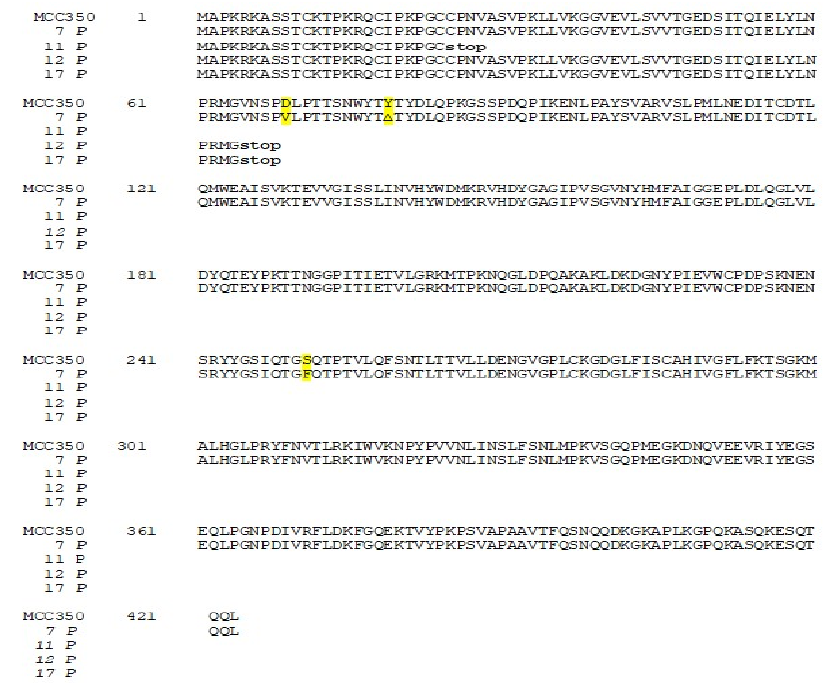
Figure 6. Amino-acid analysis of MCPyV VP1 in plasma samples. The amino-acid translation of MCPyV VP1 nucleotide sequences revealed a VP1 characterized by the Asp69Val, the Tyr79 ∆ substitutions and the Ser251Phe change in 7 P (highlighted in yellow). A stop codon did not allow the complete VP1 translation in 11 P (24 aa), 12 P (64 aa), and 17 P (64 aa).